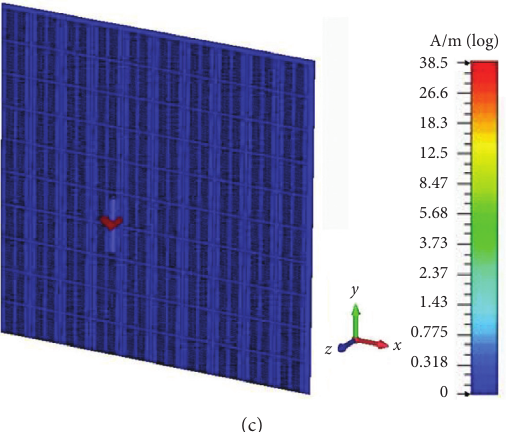
Figure 15: The simulation surface current results of dipole antenna within ICPW-EBG reflector: (a) 1.8GHz, (b) 2.45GHz, and (c) 3.7 GHz.